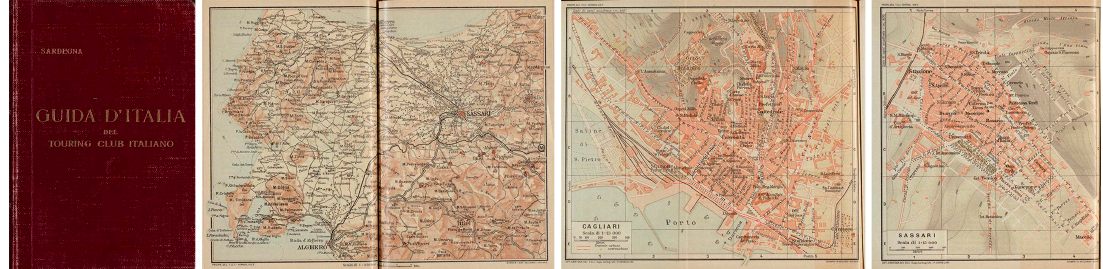
Figure 1. Guida d’Italia del Touring Club Italiano. Sardegna,